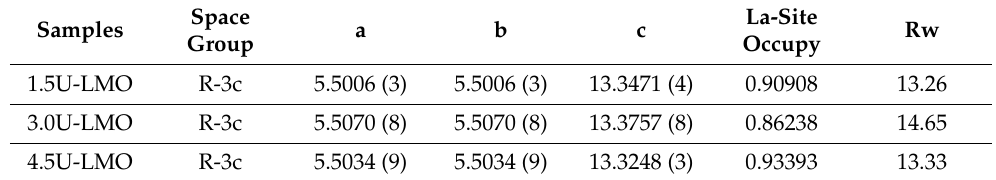
Table 1. The obtained values with Rietveld refinement method from XRD patterns.